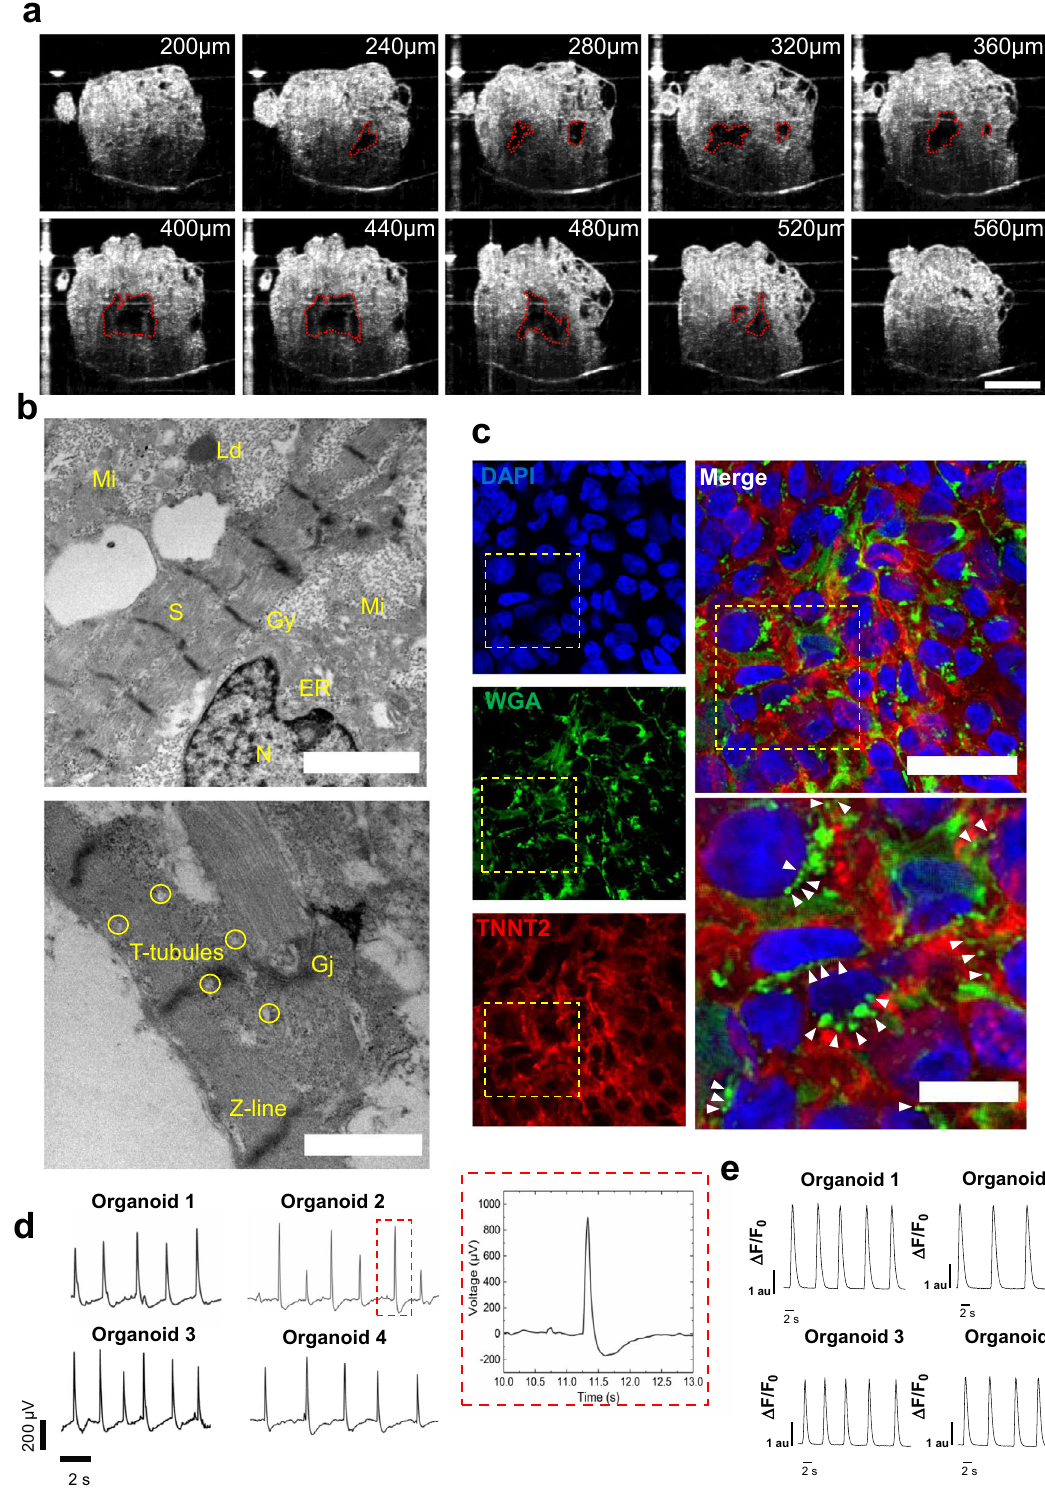
Fig. 6 Heart organoids recapitulate functional and structural features of the developing heart. a Optical coherence tomography images showing cross- sections through an organoid, revealing chambers; scale bar: 500 µ m. b TEM images of hHOs showing endoplasmic reticulum (ER), gap junctions (Gj), glycogen granules (Gy), lipid droplets (Ld), mitochondria (Mi), nucleus (N), and sarcomeres (S); scale bars: 2 µ m (top), 1 µ m (bottom). c Immuno fl uorescence images of myocardial tissue in hHOs showing WGA staining of T-tubule-like structures (green); white arrowheads indicate representative T-tubule-like structures between cardiomyocytes; scale bar: 50 µ m, inset: 20 µ m. d Electrophysiology recordings of 4 organoids on microelectrode array spanning 15 s and a representative action potential wave (inset). e Ca 2 + transients in 4 representative hHOs after two weeks of